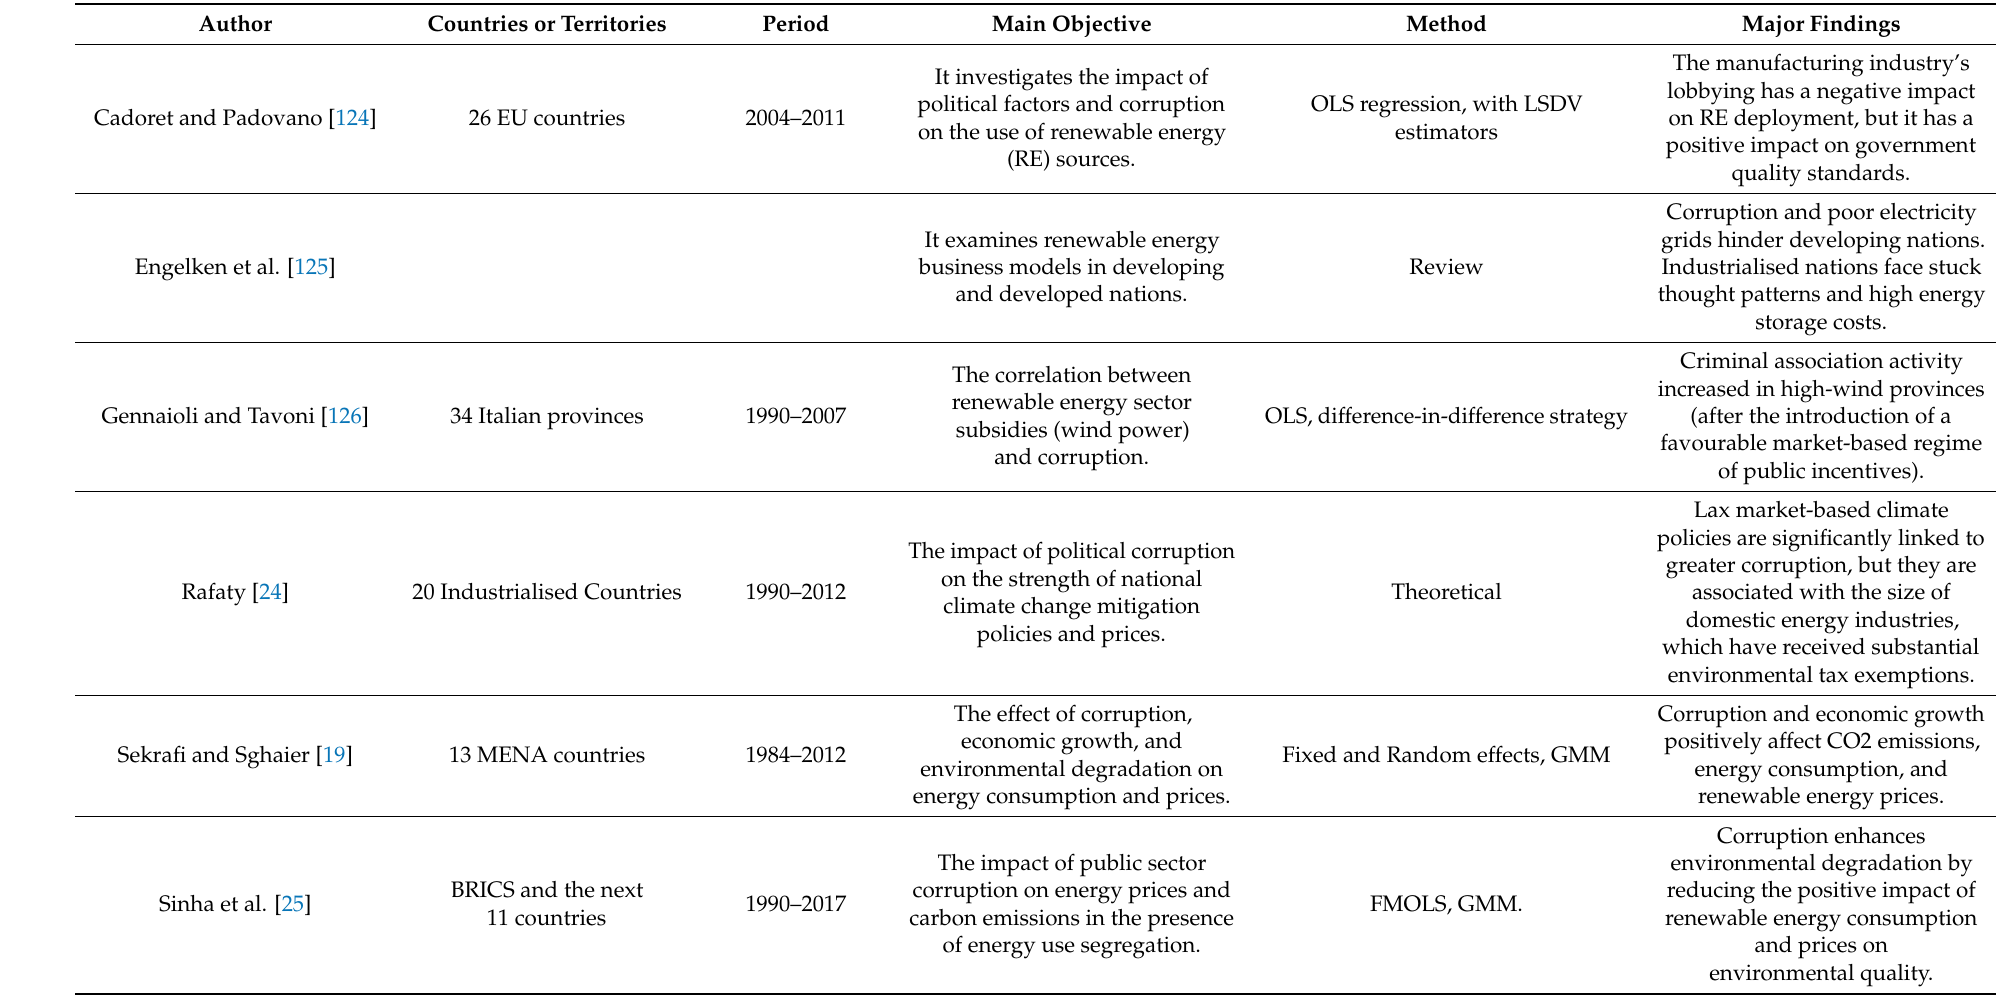
Table 2. Selected literature on the relationship between corruption and renewable energy consumption and